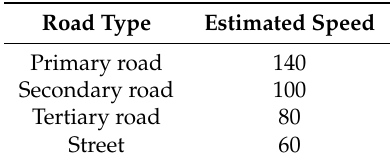
Table 2. Estimated speeds in emergencies used in costs